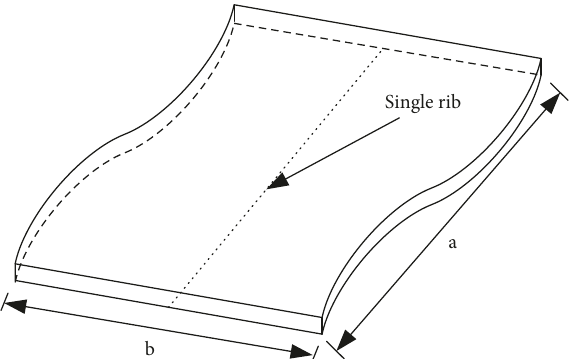
Figure 4: Straight rib when the plate is buckling.